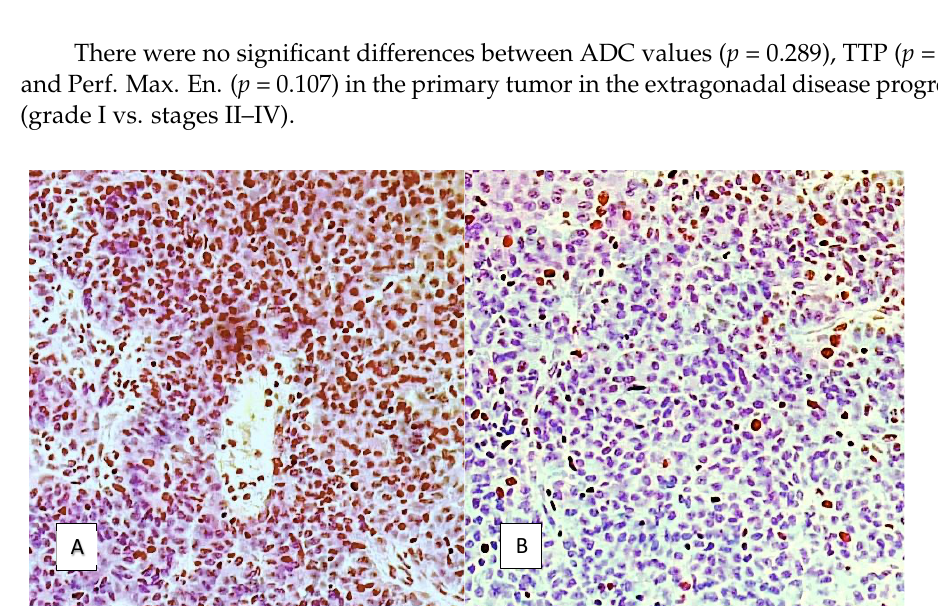
Figure 5. Ki67 staining of the nucleus in high-grade serous EOC, magnification 20×. ( A ) High expression, >90% positive stain cell nuclei; ( B ) low expression, 10% stain cell nuclei.